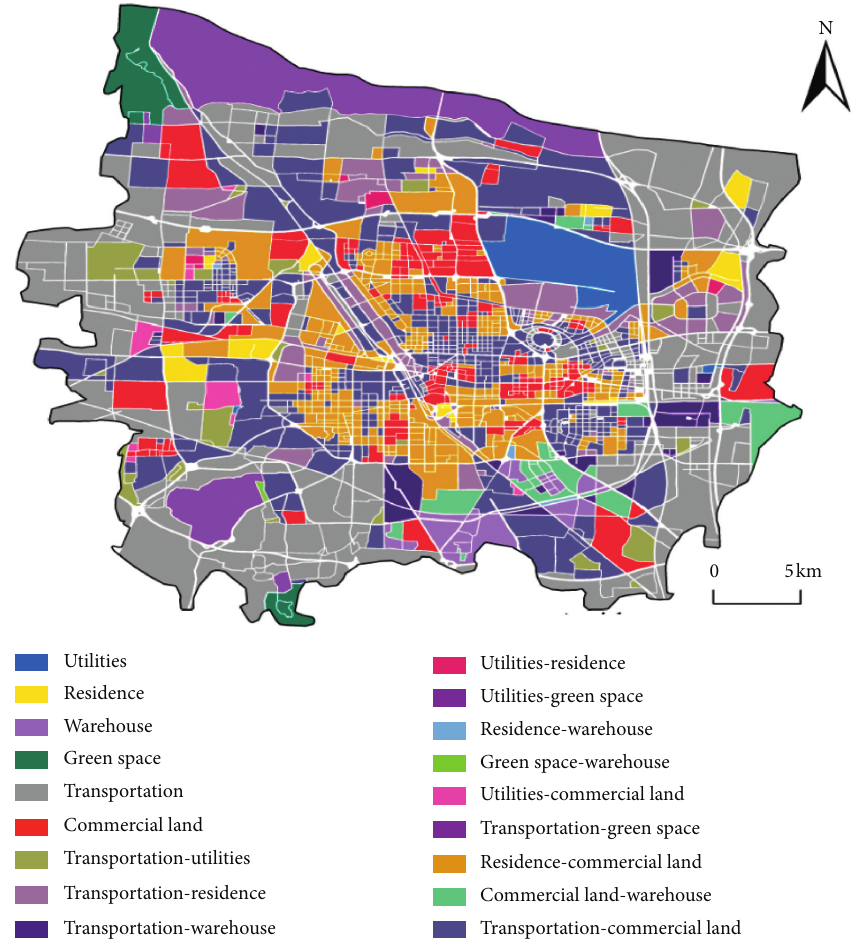
Figure 2: Functional area map of Zhengzhou. Table 4: Statistical table of functional